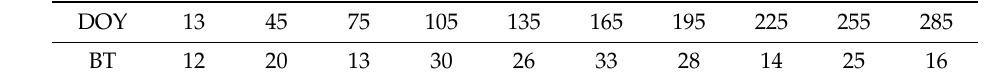
Table A1. Day of year (DOY) and Bright Temperature